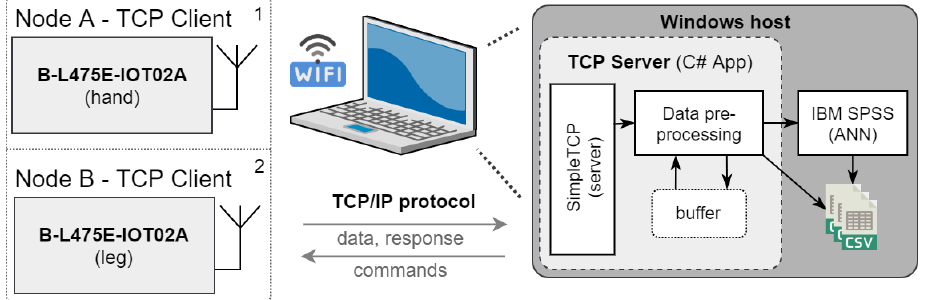
Figure 5. Data transfer chain of the measurement system.